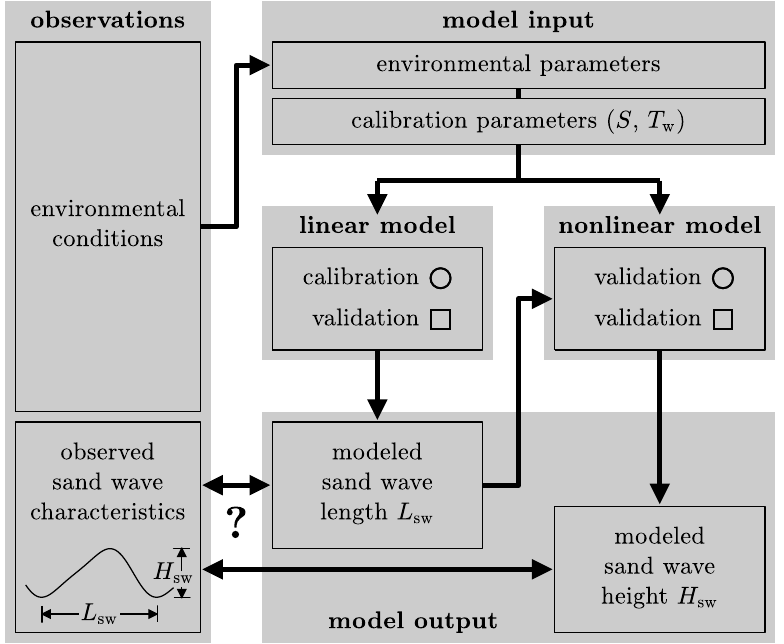
Figure 1. Schematic representation of method (Section 2), showing how observations are translated into model input, how the linear model is used for calibration on sand wave lengths (and validation), and the nonlinear model for validation of sand wave